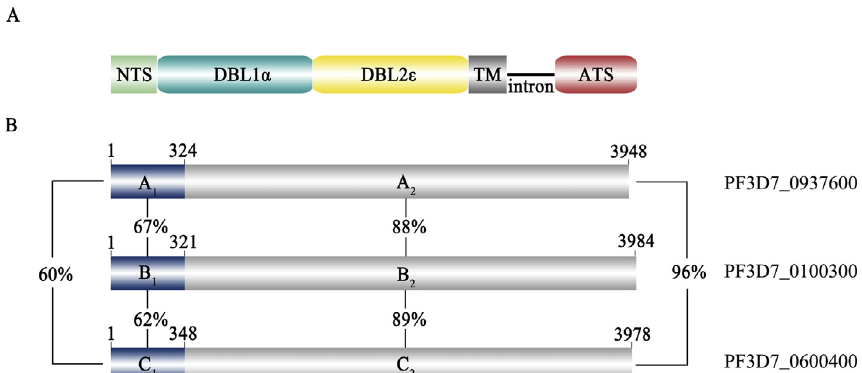
Figure 1. Schematic structures of the three var3 genes and the encoded proteins. A. The domain architecture of the ‘‘min-PfEMP1s’’ encoded by the three var3 genes. NTS: N -Terminal Segment; DBL: Duffy Binding-Like; ATS: Acidic Terminal Segment; TM: Transmembrane region. B. The variable (A1, B1, and C1) and conserved (A2, B2, and C2) regions and the identity in percentage between two